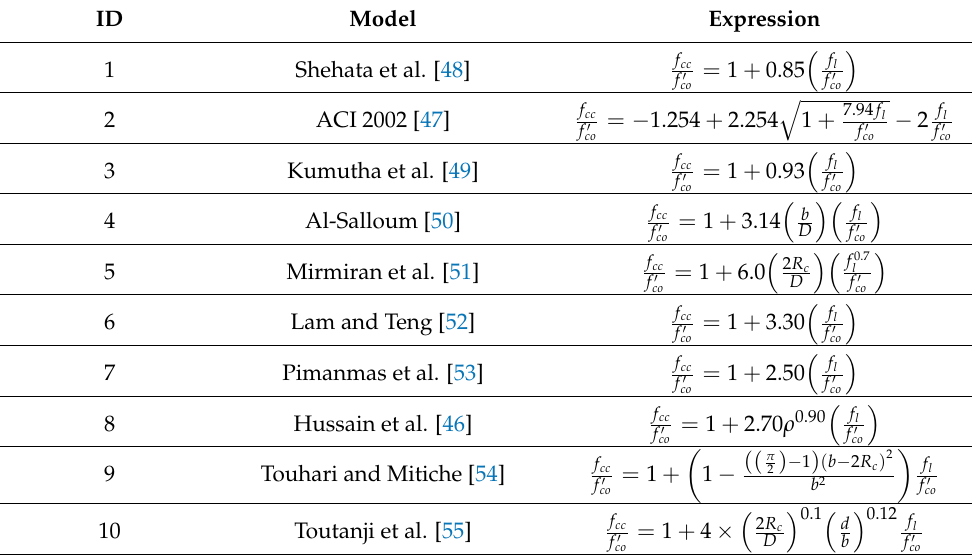
Table 4. Existing ultimate compressive strength